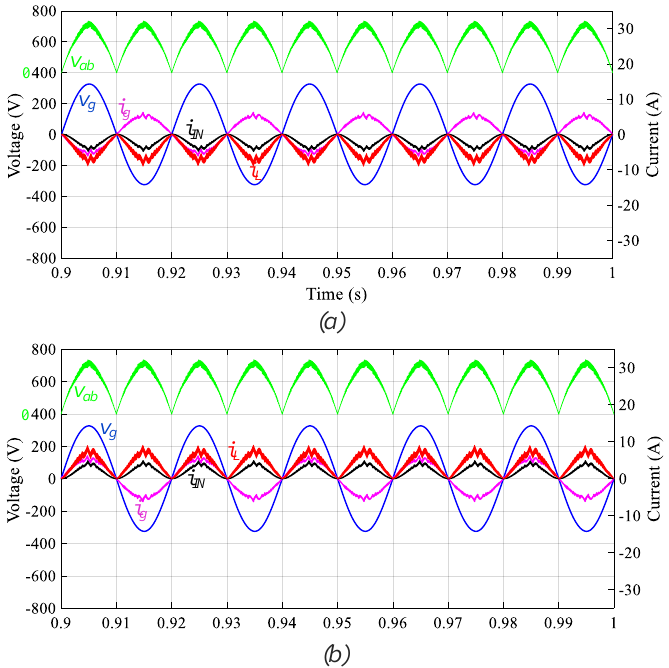
Figure 8. Simulation results for Vin = 350 V, Pin = 850 W in rectifier mode ( a ) and inverter mode ( b ).